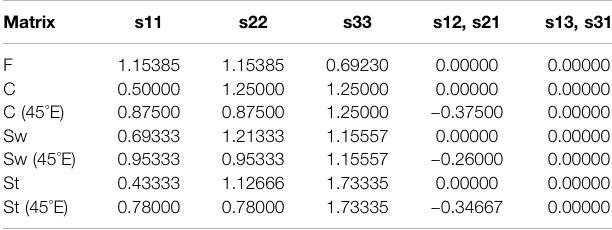
and to the TK03.GAD distributions in presence of bedding tilt. Matrix